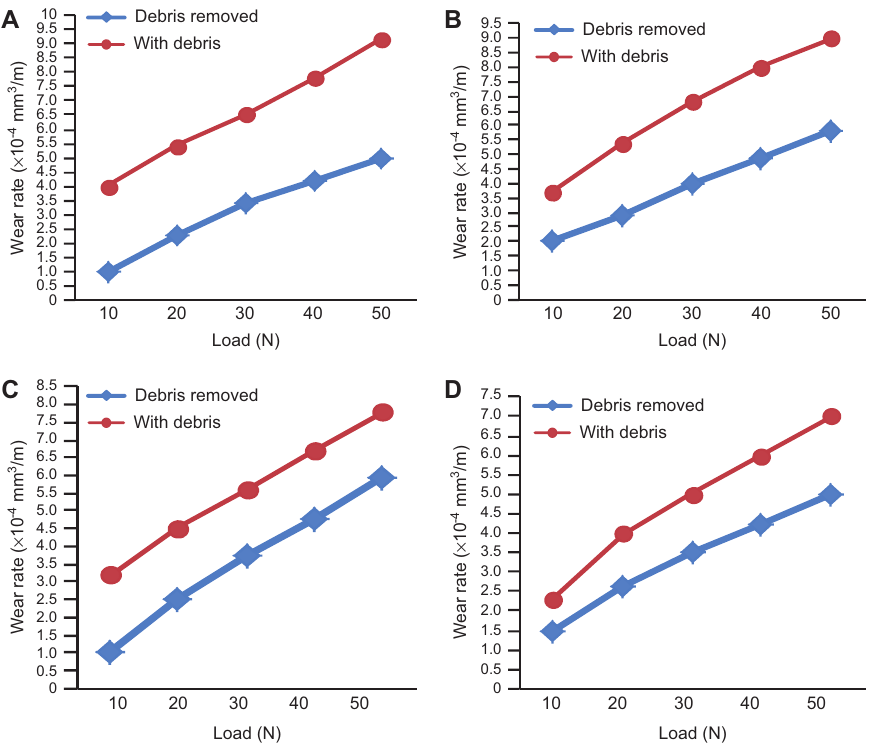
Figure 5 Variation of the wear rate with the load or the tests carried out with and without the removal of wear debris, as observed in the composites designated as (A) 0.5 wt% , (B) 1.5 wt% , (C) 2.5 wt% , (D) 3.5 wt% TiO in the wear is relatively more when the wear debris is removed during the dry sliding wear test as shown in Figure 5, it may be inferred that the beneficial role of the wear debris in promoting wear resistance through the for- mation of the transfer layer is more prominent than its contribution to the increased volume loss through three- body wear. At higher loads, the oxide debris is expected to get better compacted to form the transfer layer, spread over a larger area of the sliding surface. However, the volume loss under such circumstances takes place also by flaking of the transfer layer during sliding, apart from the processes of adhesion, microcutting, and abrasion. At